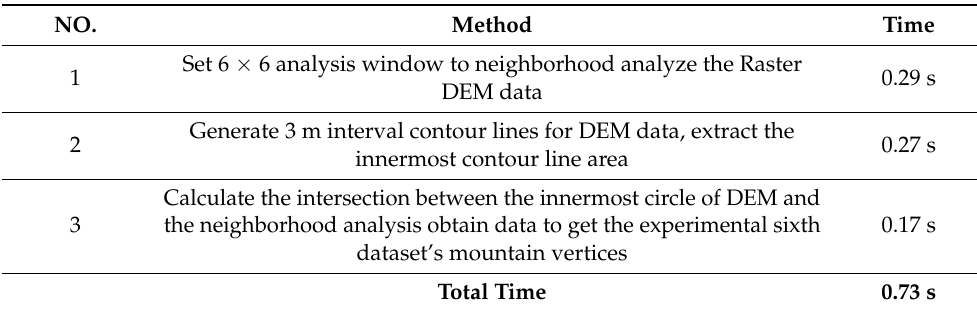
Table 21. The time spent in extracting mountain vertices for the sixth dataset using the Contour Line and Neighborhood Analysis Overlay